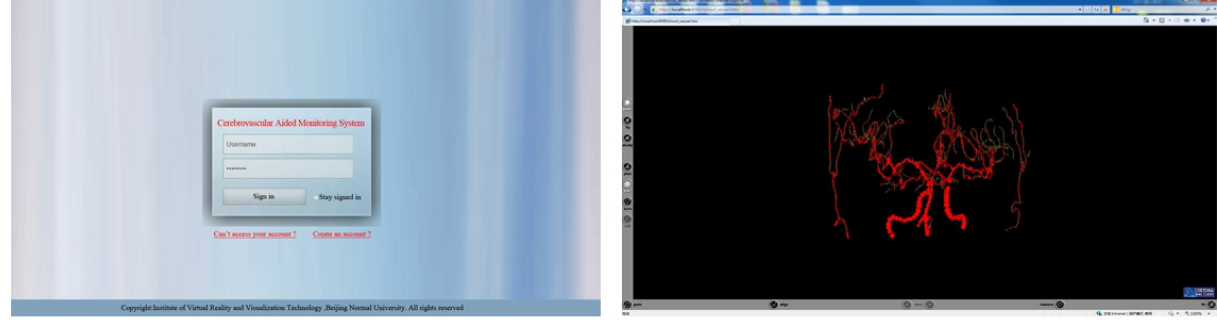
Figure 13. The interface of the network client .Left: Landing interface at remote Client; right: The Ball B-spline structure at remote client.